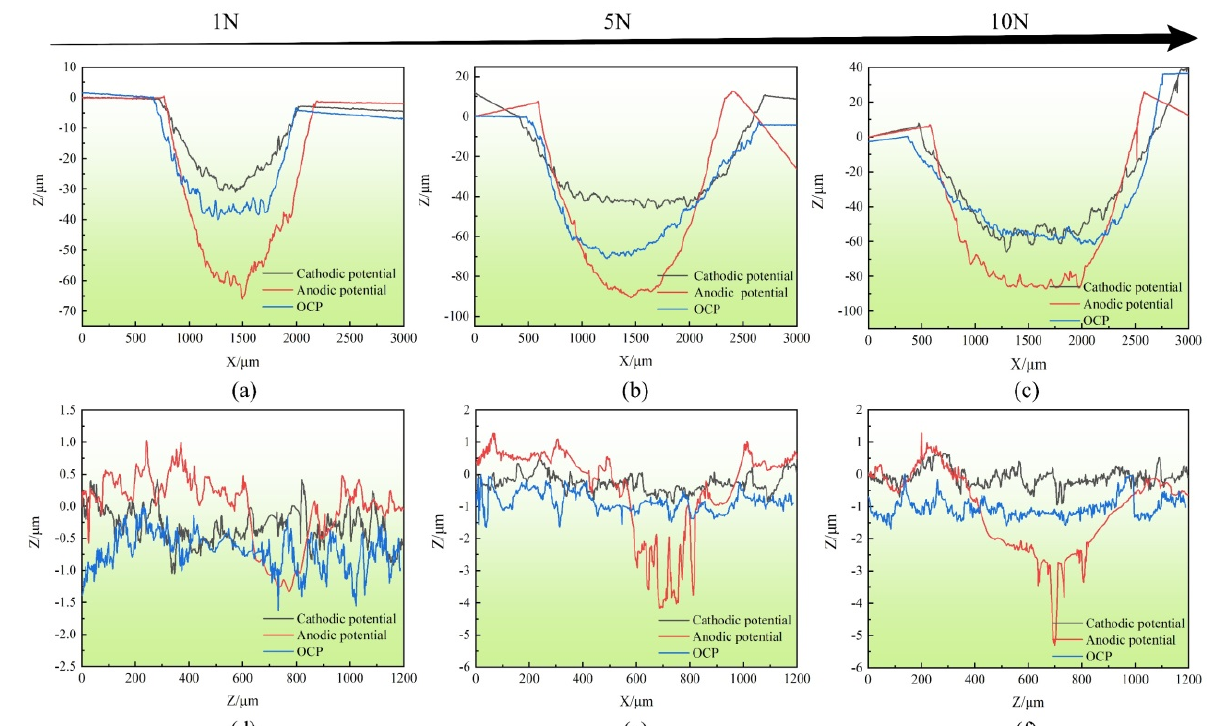
Figure 10. Wear profile after the tribocorrosion test of the ( a–c ) raw sample and the ( d–f ) nitrided sample under different conditions.